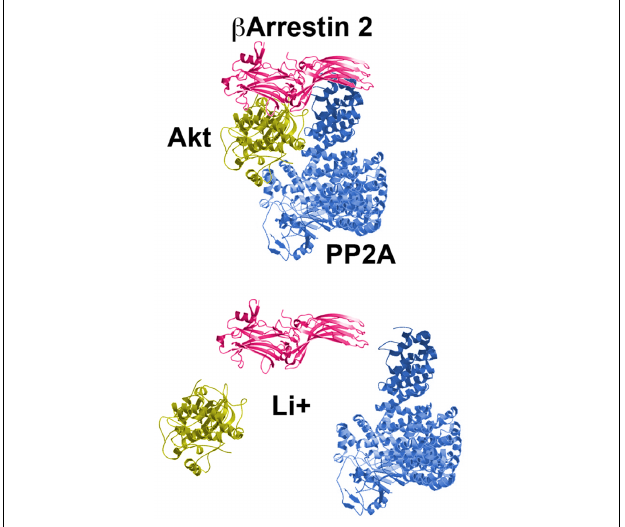
FIGURE 3 |The mood stabilizer lithium disrupts the D2R-associated protein complex composed ofAkt, PP2A, and beta-arrestin 2. The consequences are an overactivation of Akt, inhibition of GSK3 and correlated Akt/GSK3-regulated behaviors. also acting on other “non-dopamine” receptor types